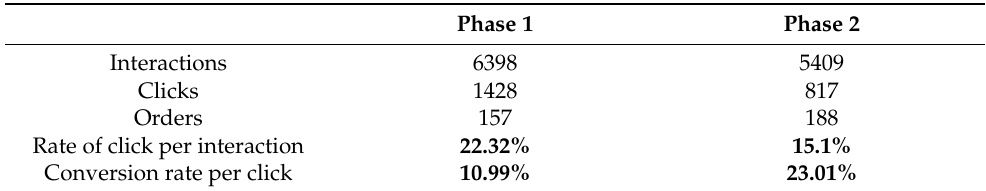
Table 4. The rates for each interaction and click.